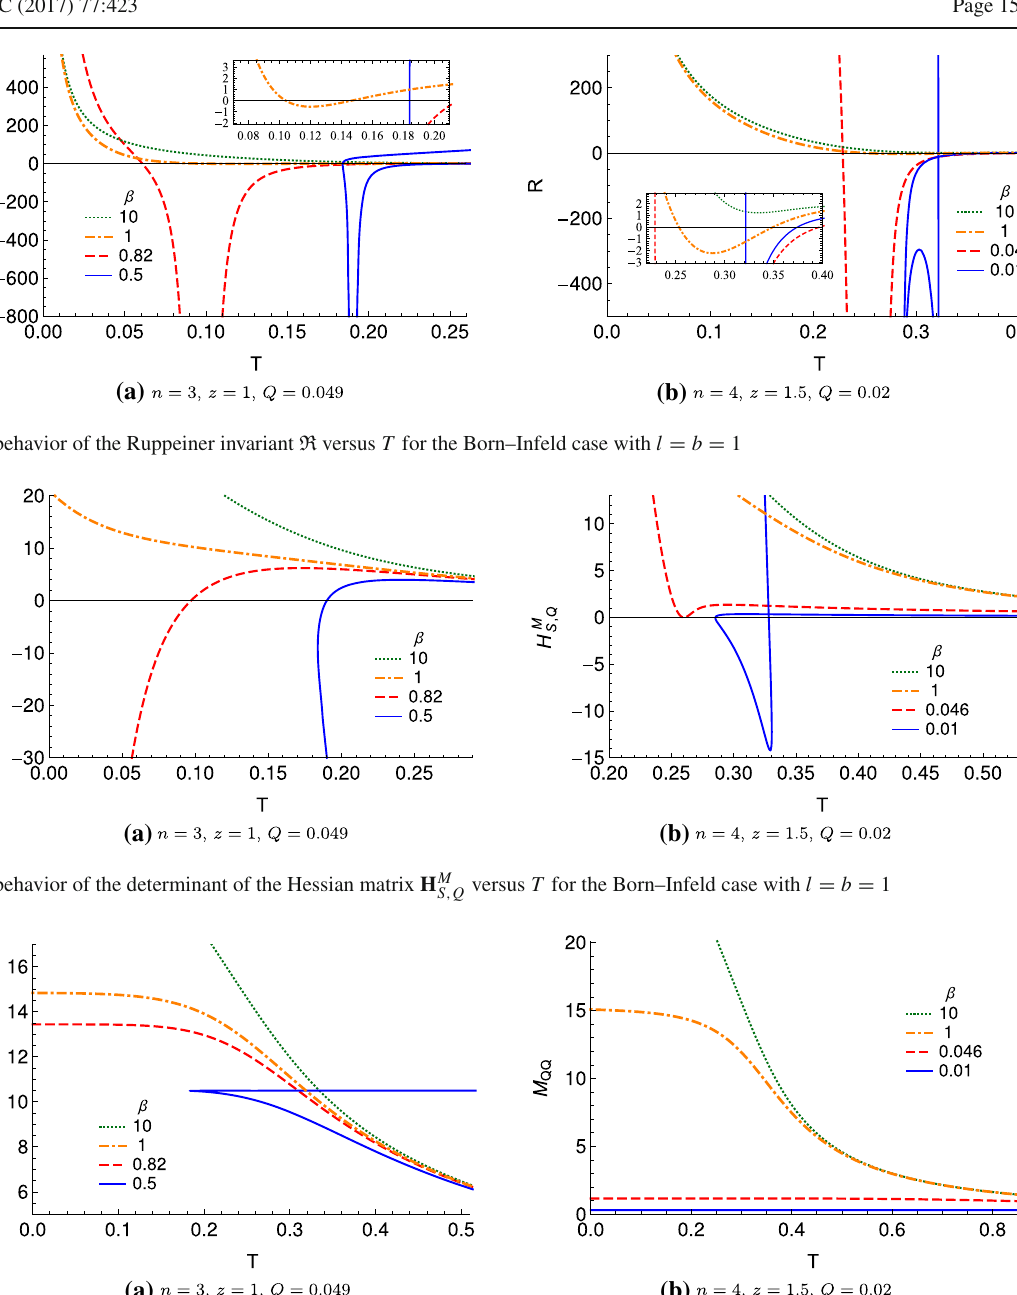
Fig. 10 The behavior of M QQ versus T for Born–Infeld case with l = b = 1